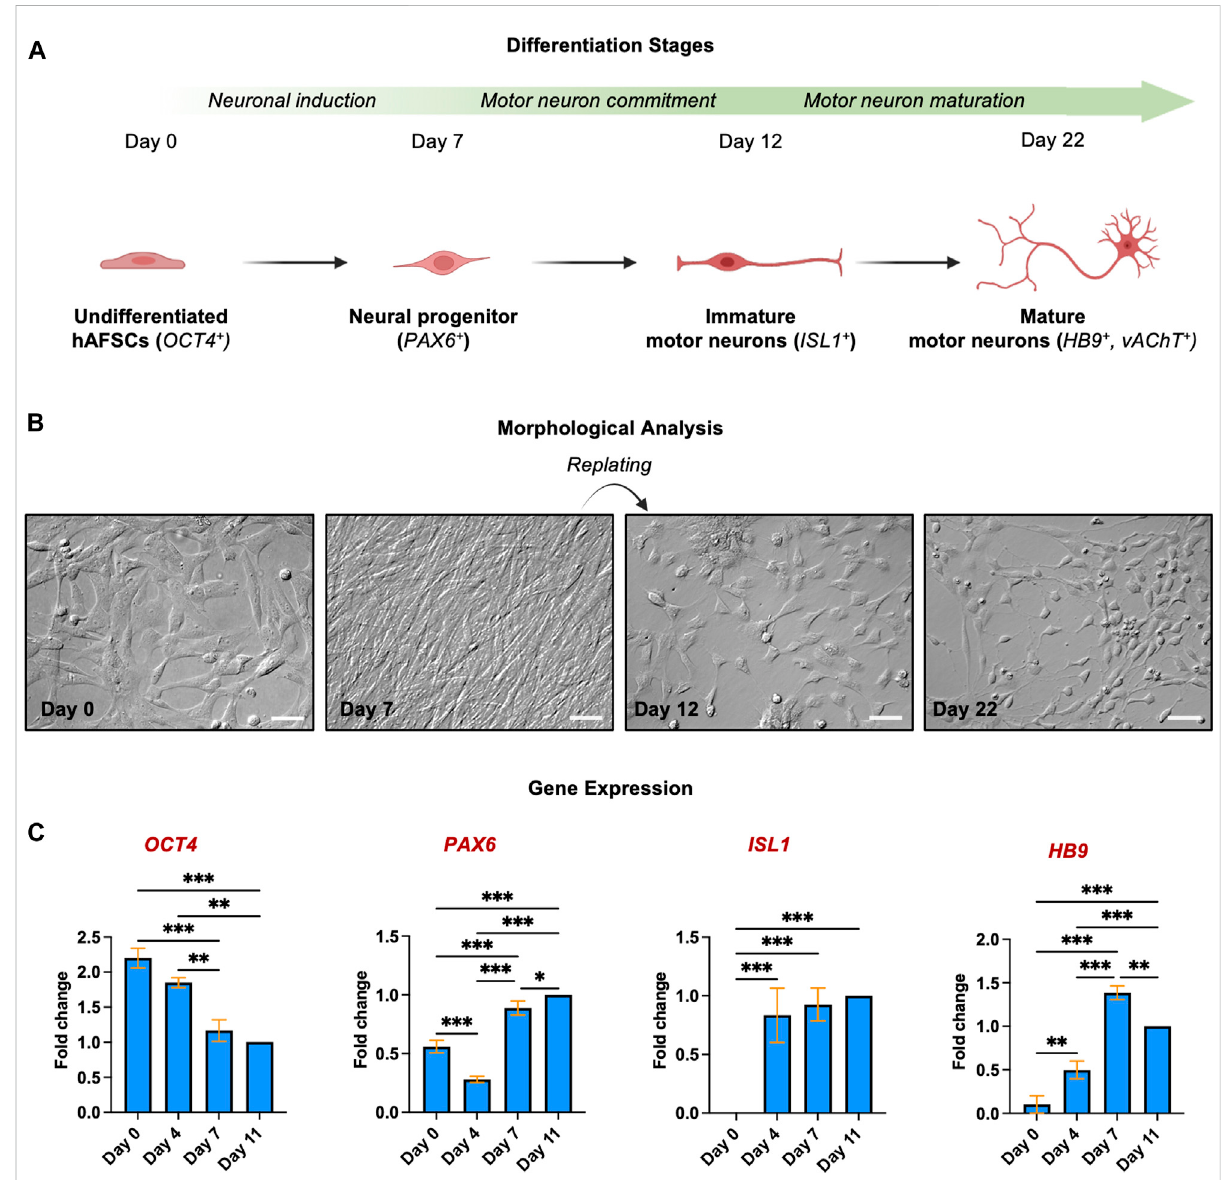
FIGURE 2 Morphological and gene expression analysis of hAFSC during the differentiation into MNs (A) Schematic representation of key points of MN differentiation. (B) Morphological analysis of different differentiation steps. Magni fi cation 20x, scale bar 50 µm. Pictures are representative of 3 independent experiments. (C) Gene expression of OCT4, PAX6, ISL1 and HB9 was quanti fi ed in hAFSCs by qPCR at different time points during the differentiation process, as indicated. The fold changes were expressed in relation to day 11. 18S was used as reference gene. The graphs show the Mean ± SD of 3 independent experiments * p <